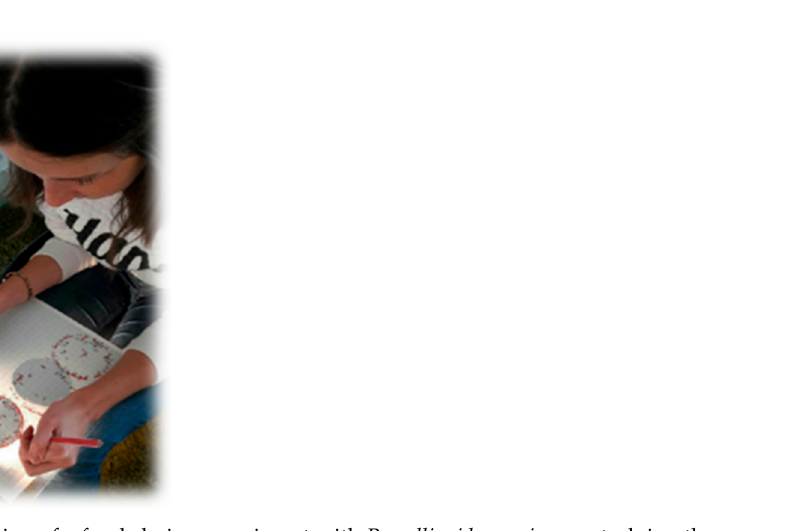
Figure 5. Evaluation of a food choice experiment with Porcellionides pruinosus studying the consump- tion of different pathogens at the Plant Protection Institute of the Hungarian University of Agriculture and Life Sciences (MATE) (Photo: Nóra Balázs, Hungary, Gödöll ő , 2016).